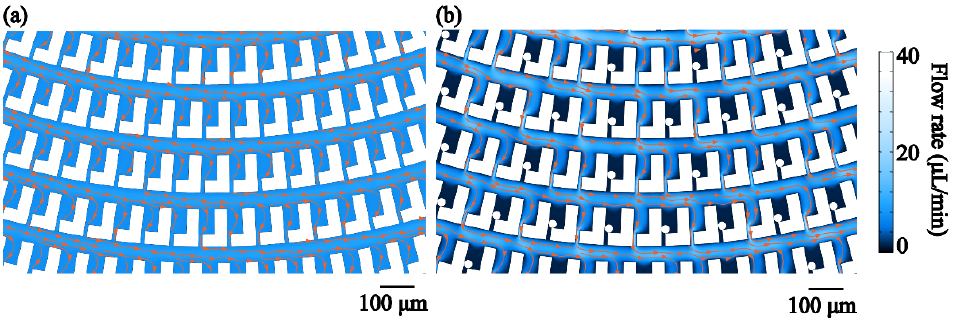
Figure 5. Simulation of the particle trapping. ( a ) The traps are empty. ( b ) Some traps capture the particles. Orange lines indicate the stream lines and the direction of the flow.